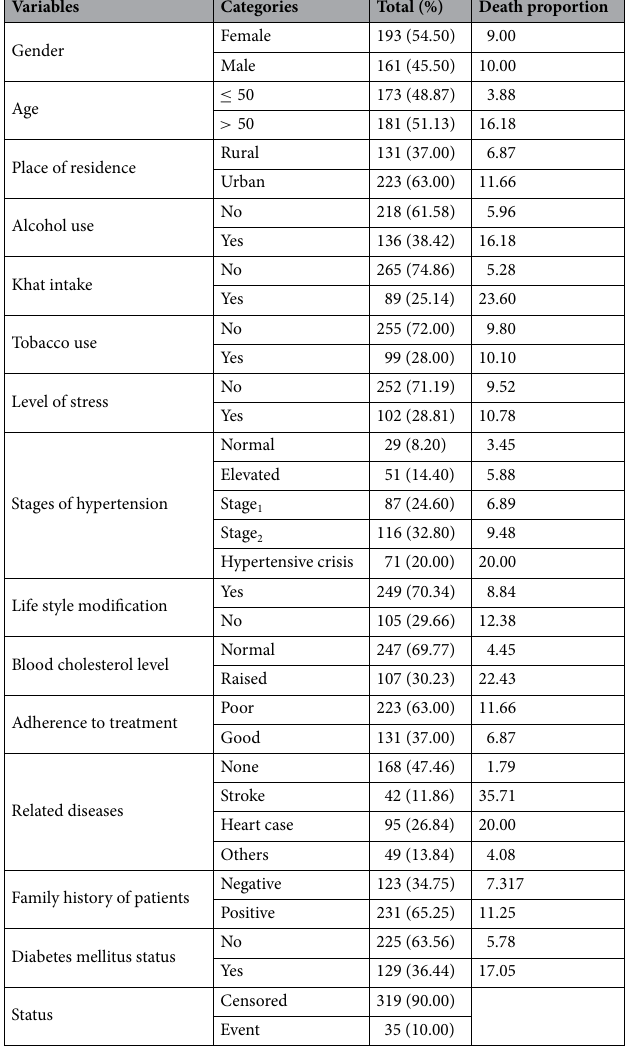
Table 1. Baseline categorical characteristics for hypertension patients at Arba Minch General Hospital from January 2012 to February 2020.